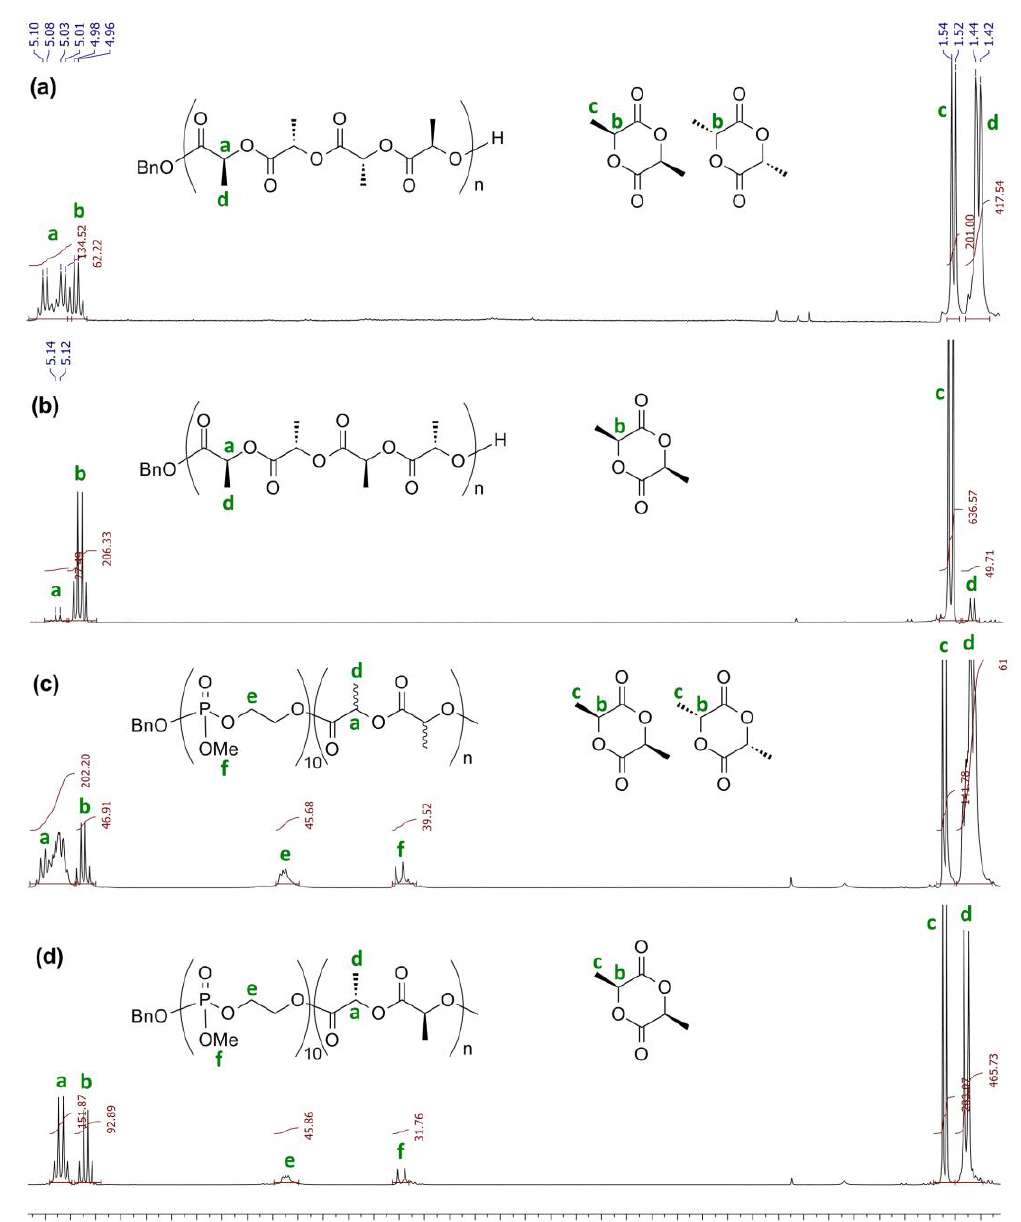
Figure 3. Fragments of 1 H NMR spectra of PLAs obtained from rac -LA and L -LA in polymerization experiments (5 ◦ C, 10 min, 1 M monomer solutions, LA/Mg ratio 100:1): ( a ) Homopolymerization of rac -LA; ( b ) Homopolymerization of L -LA; ( c ) Polymerization of rac -LA initiated by BnO(MeOEP) 10 -Mg-BHT; ( d ) Polymerization of L -LA initiated by BnO(MeOEP) 10 -Mg-BHT. Integrals